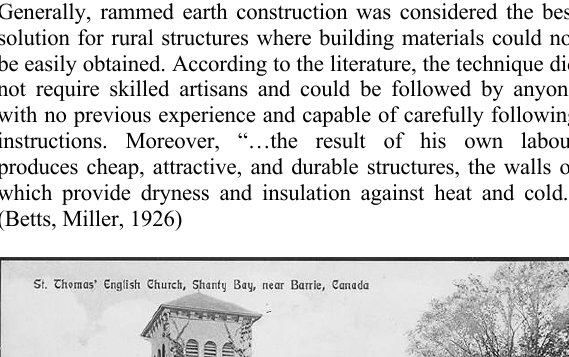
Figure 13. Cobblestone detail in Hamilton Place in Paris, Ontario, Canada (Source: